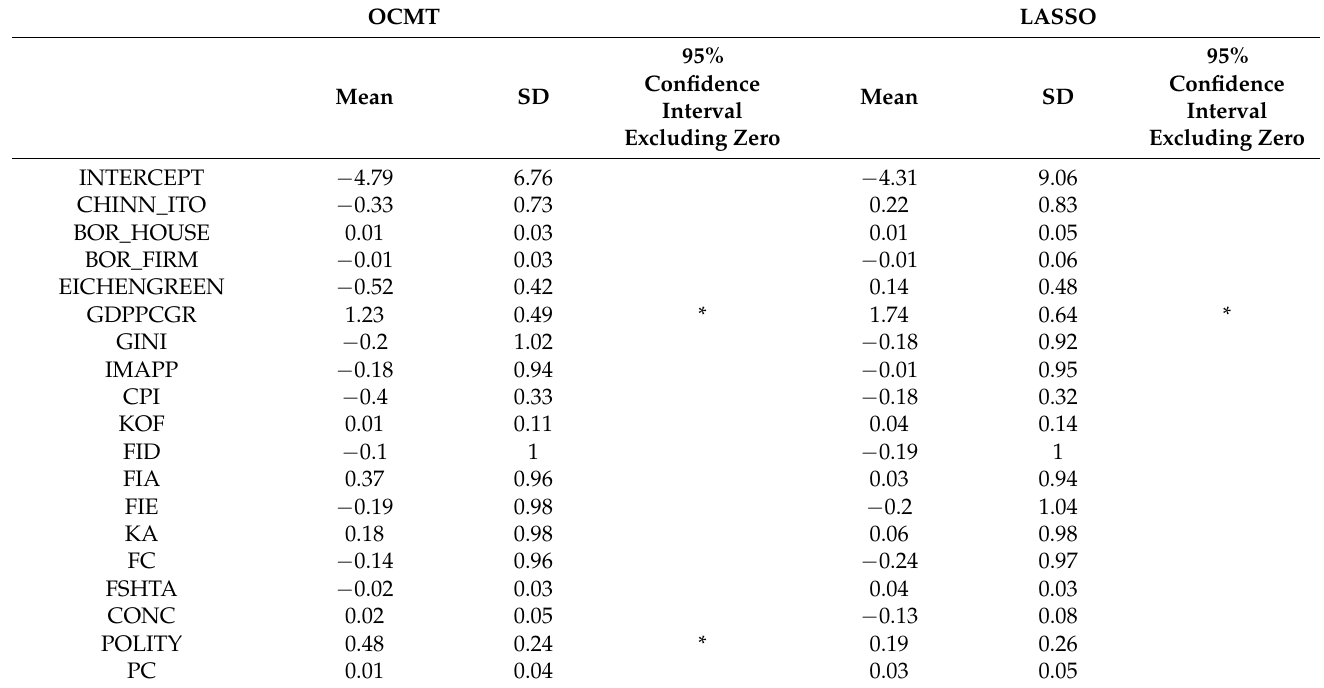
Table 7. Results for the Bayesian logit model for 2007Q3:2013Q4.